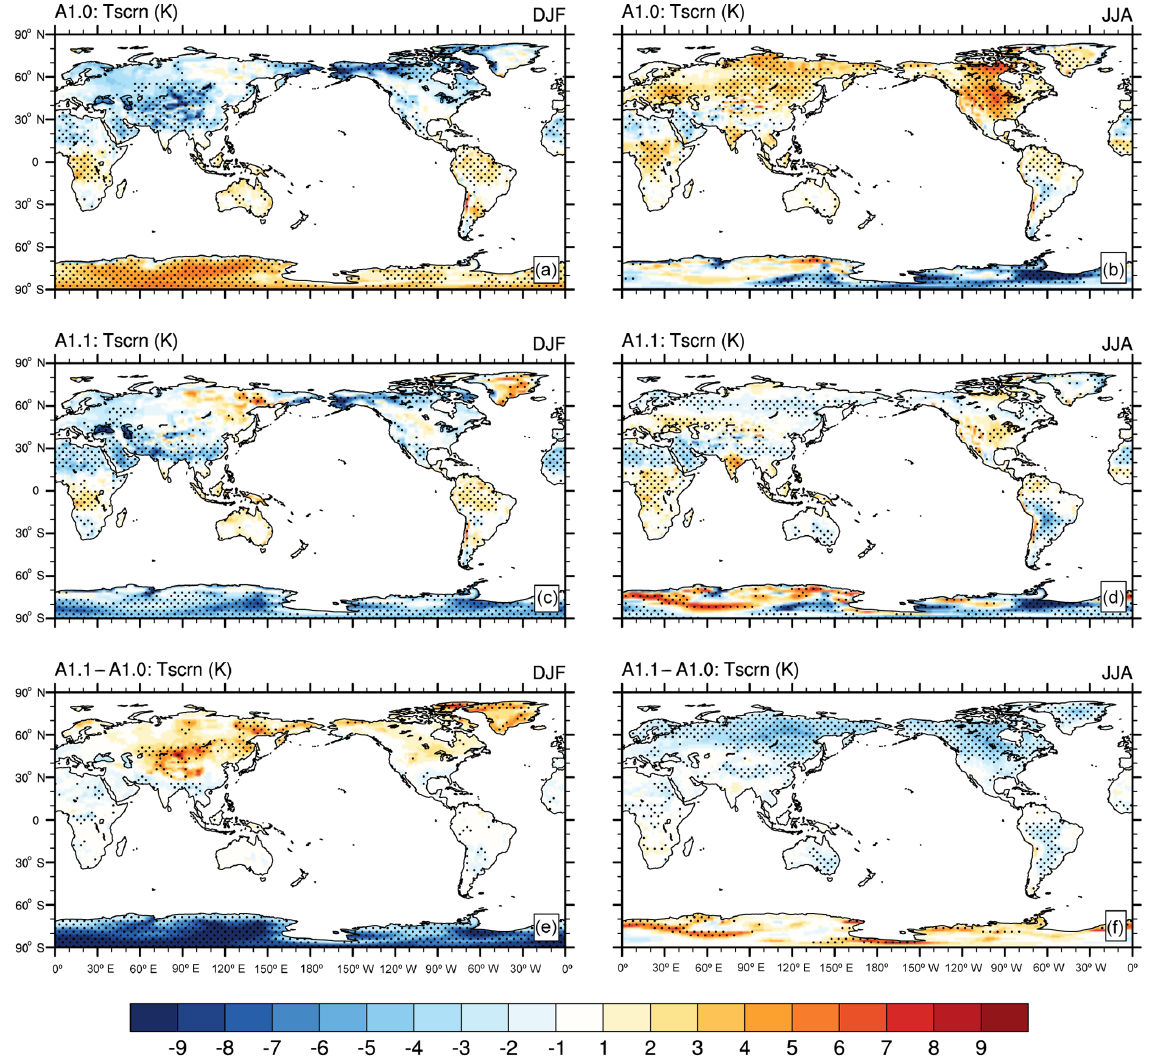
Figure 4. Seasonal mean screen temperature biases ( ◦ C) for ACCESS1.0 (a, b) and ACCESS1.1 (c, d) AMIP simulation evaluated against ERA-Interim analysis for DJF (left column) and JJA (right column). The model screen temperature difference, ACCESS1.1 minus AC- CESS1.0, is shown in panels (e, f) . Areas of statistical significance based on the modified t test are shown in all panels via stippling.